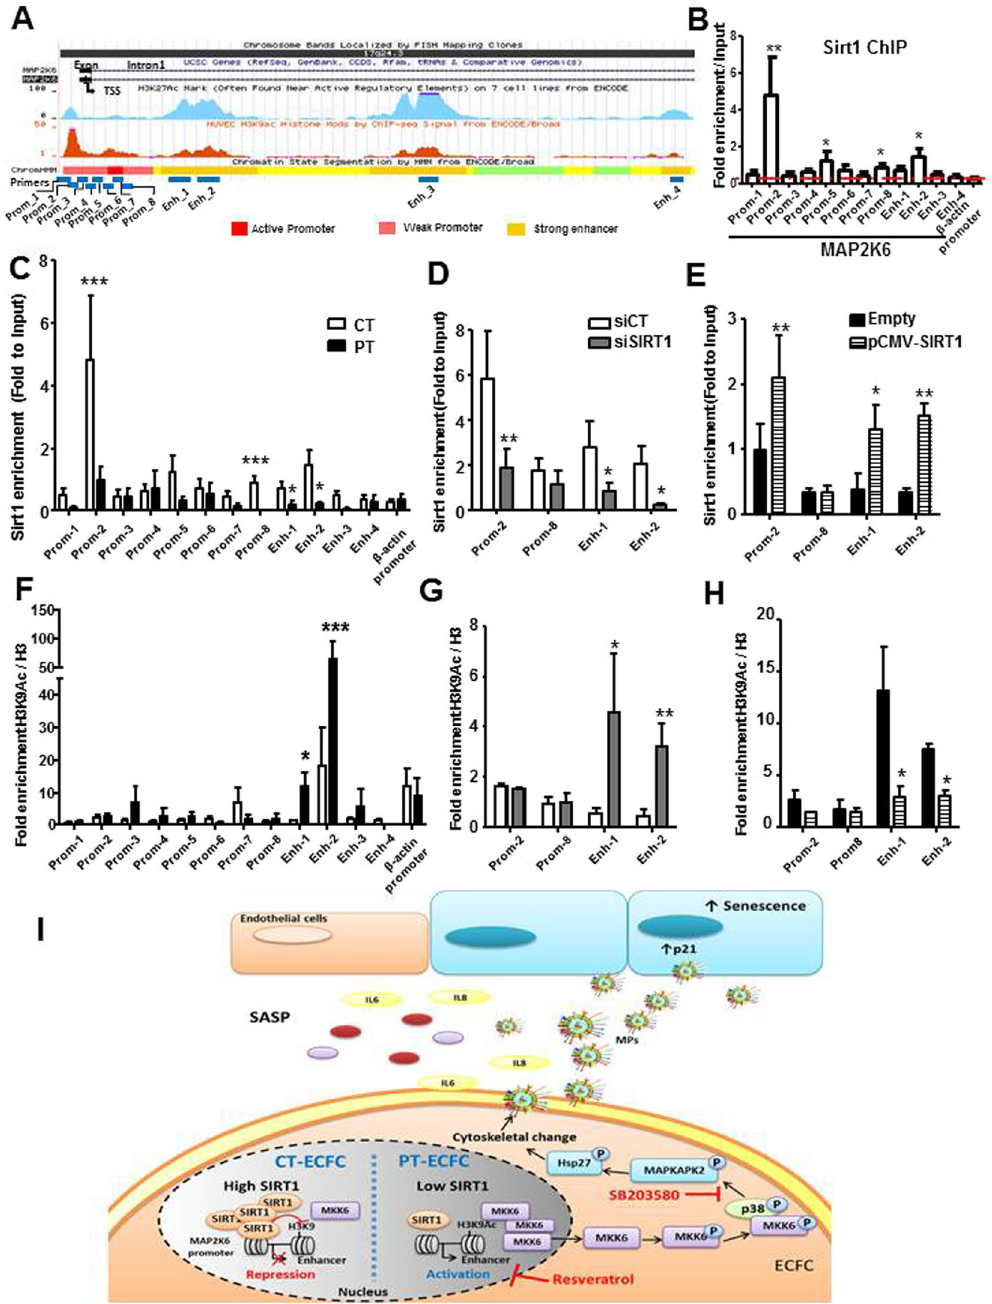
Figure 7. SIRT1 negatively regulates MKK6 transcription through epigenetic chromatin modification. ( A ) Genome browser view showing the genomic region surrounding the transcriptional start site (TSS, arrow) of human MAP2K6 (MKK6). Encode tracks illustrate the presence of H3K27ac and H3K9ac marks of the ChIP-seq and the promoter and enhancer regions in HUVEC. The annealing positions of primers used for the ChIP experiments are indicated at the bottom of the figure ( B ) ChIP assays were performed with chromatin prepared from CT-ECFC. The chromatin was immunoprecipitated with the antibody against SIRT1, and the precipitated genomic DNA was analyzed via RT-PCR using primers for different areas of the MAP2K6 promoter and enhancer region. The actin promoter served as a negative control. ( C and F ) ChIP assays were performed with chromatin prepared from CT- or PT-ECFC (N = 9 vs. 6). Chromatin was immunoprecipitated with the antibodies against SIRT1 (C) , H3 and H3K9Ac (F) . ( D and G ) ChIP assays were performed with CT-ECFC transfected with scrambled siRNA (siCT) or SIRT1 siRNA (siSIRT1) (N = 3–5). Chromatin was immunoprecipitated with antibodies against SIRT1 (D) , H3 and H3K9Ac (G) . The precipitated genomic DNA was analyzed via RT-qPCR using primers for the specific promoter (Prom_2 and 8) and the enhancer (Enh_1 and 2) regions. ( E and H ) ChIP assays of PT-ECFC transfected with pCMV (Empty) or pCMV-SIRT1 (N = 3). The chromatin was immunoprecipitated with antibodies against SIRT1 (E) , H3 and H3K9Ac (H) .